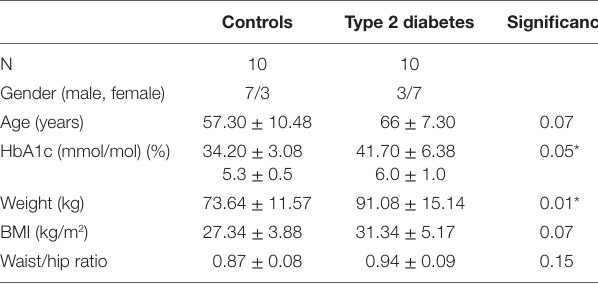
Table 1 | Baseline patient